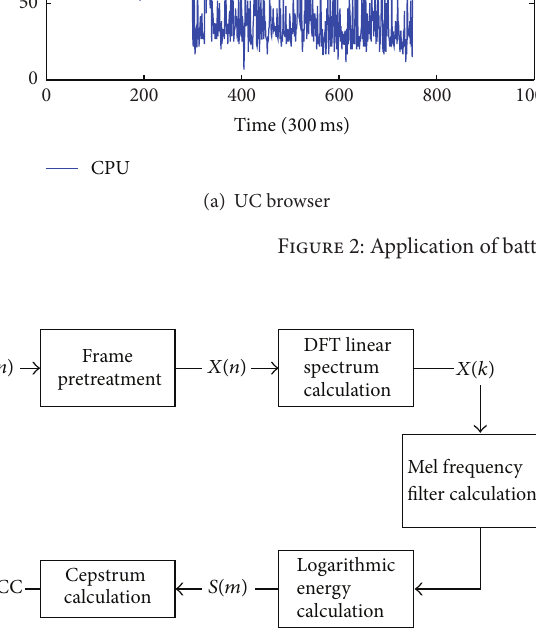
Figure 3: MFCC calculation